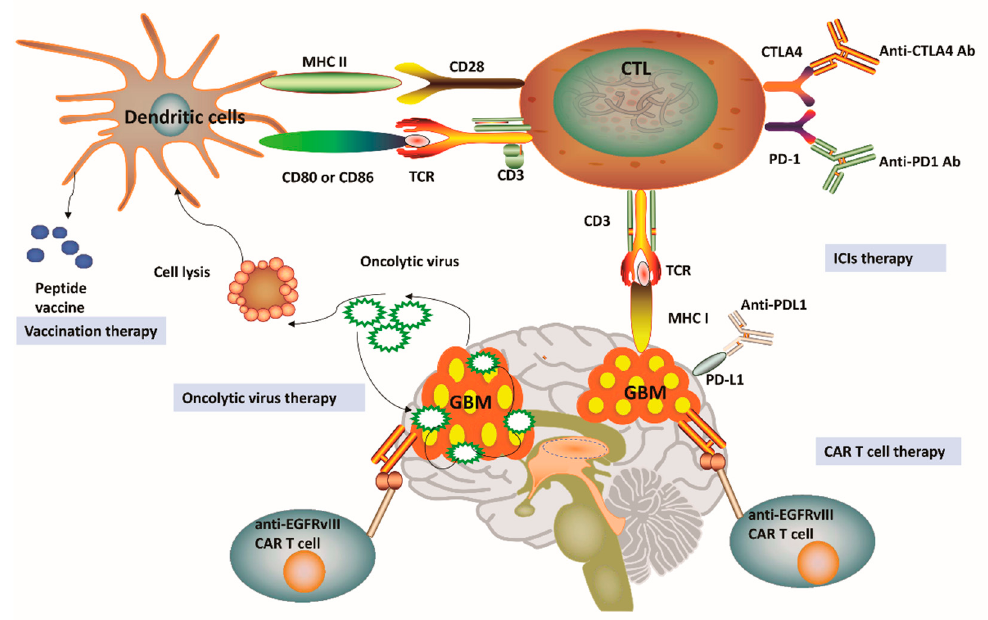
Figure 2. Current immunotherapy strategies for glioblastoma. ( 1 ) Vaccines for glioblastoma (GBM) treatment have been relied on dendritic cell (DC)-mediated presentation of GBM-related antigens and peptides for T-cell activation in the adaptive immune system. ( 2 ) The immunosuppression status of cytotoxic T lymphocytes (CTLs) can be relieved by the application of immune-checkpoint inhibitors (ICIs), including anti-programmed cell death protein 1 (PD-1), anti-cytotoxic T lymphocyte protein 4 (CTLA-4) and anti-programmed cell death 1 ligand 1 (PD-L1). ( 3 ) Genetically engineered chimeric antigen receptor (CAR) T cells can generate artificial T-cell receptors with high affinity to cancer-specific antigens. ( 4 ) Genetic engineering has also been applied in oncolytic viral treatment to medicate cancer cell lysis and promote tumor necrosis. MHC, Major histocompatibility complex; TCR, T-cell receptor; EGFRvIII, Epidermal growth factor receptor variant III.